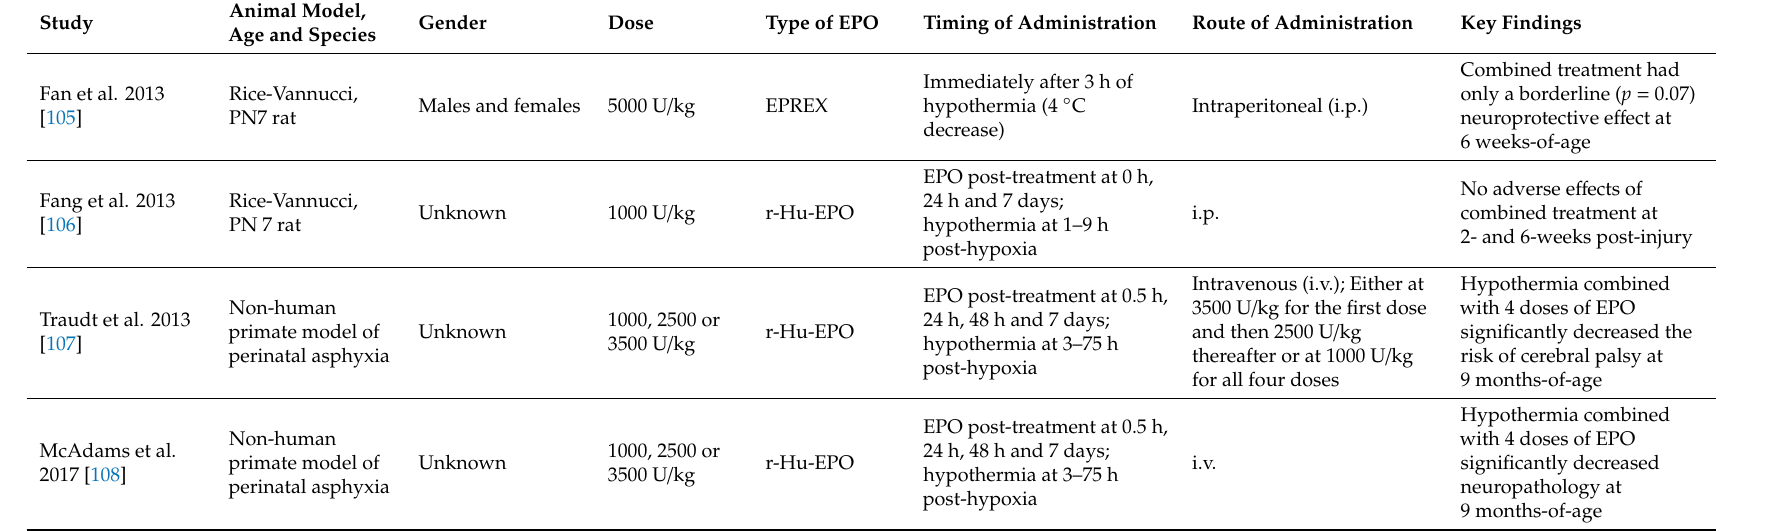
Table 2. Animal studies on neonatal hypoxia-ischemia: E ff ect of EPO in combination with moderate